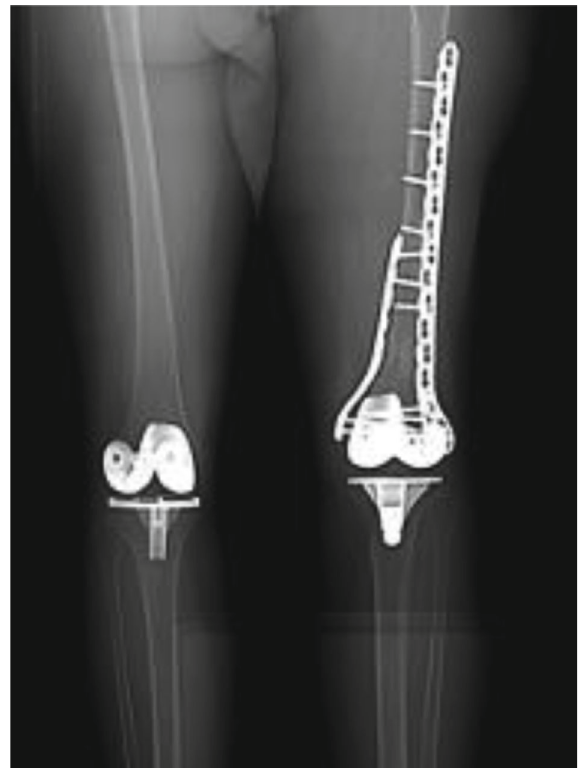
Figure 8: Postoperative follow-up AP radiograph of both knees nine months after revision surgery showing improvement in healing and satisfactory alignment.